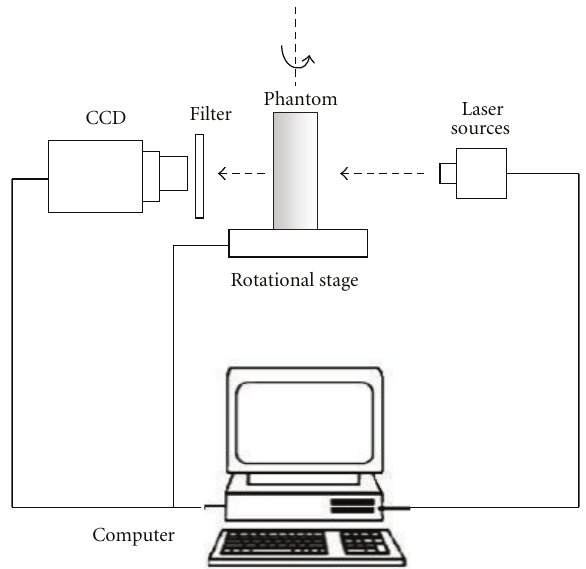
Figure 5: A schematic of FMT imaging system.